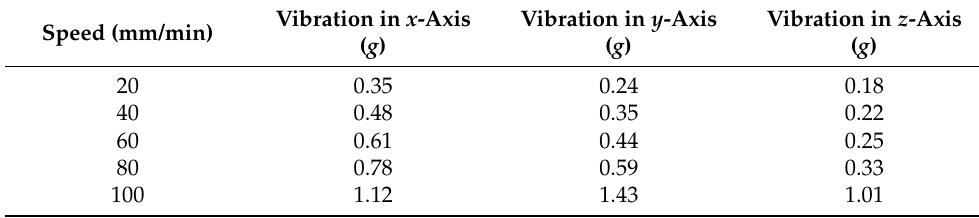
Table 10. Measured vibrations on the steel 1.2379 in multiples of gravitational acceleration ( g ). Speed